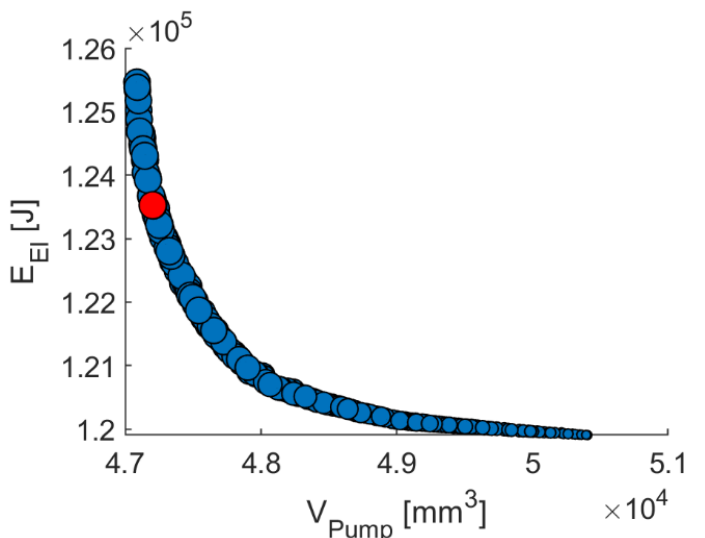
Figure 18. Selection of the most suitable tradeoff (red) from Figure 17. Circle size corresponds to the total score of a variant.